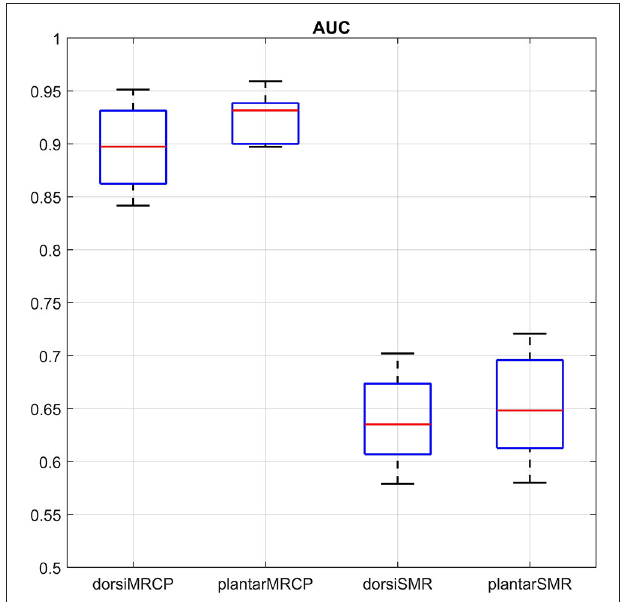
FIGURE 4 | Sample-based performance (AUC) for different movement types and processing methods. We use dorsi and plantar to represent dorsiflexion and plantar flexion for simplicity. The boxplot shows the median (central mark) and 25th/75th percentiles (edges of the box) of the AUC values.